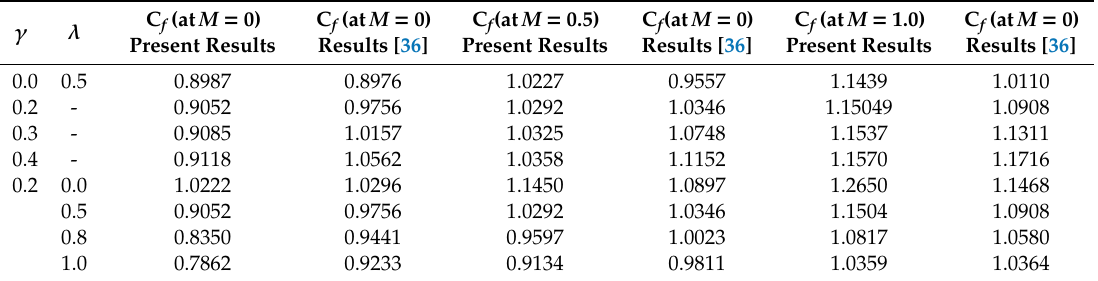
Table 1. Computed numerical values of skin friction coe ffi cient C f for numerous values of k , M , and c , when λ , M and γ , ϕ np 1 = 2%, ϕ np 2 =